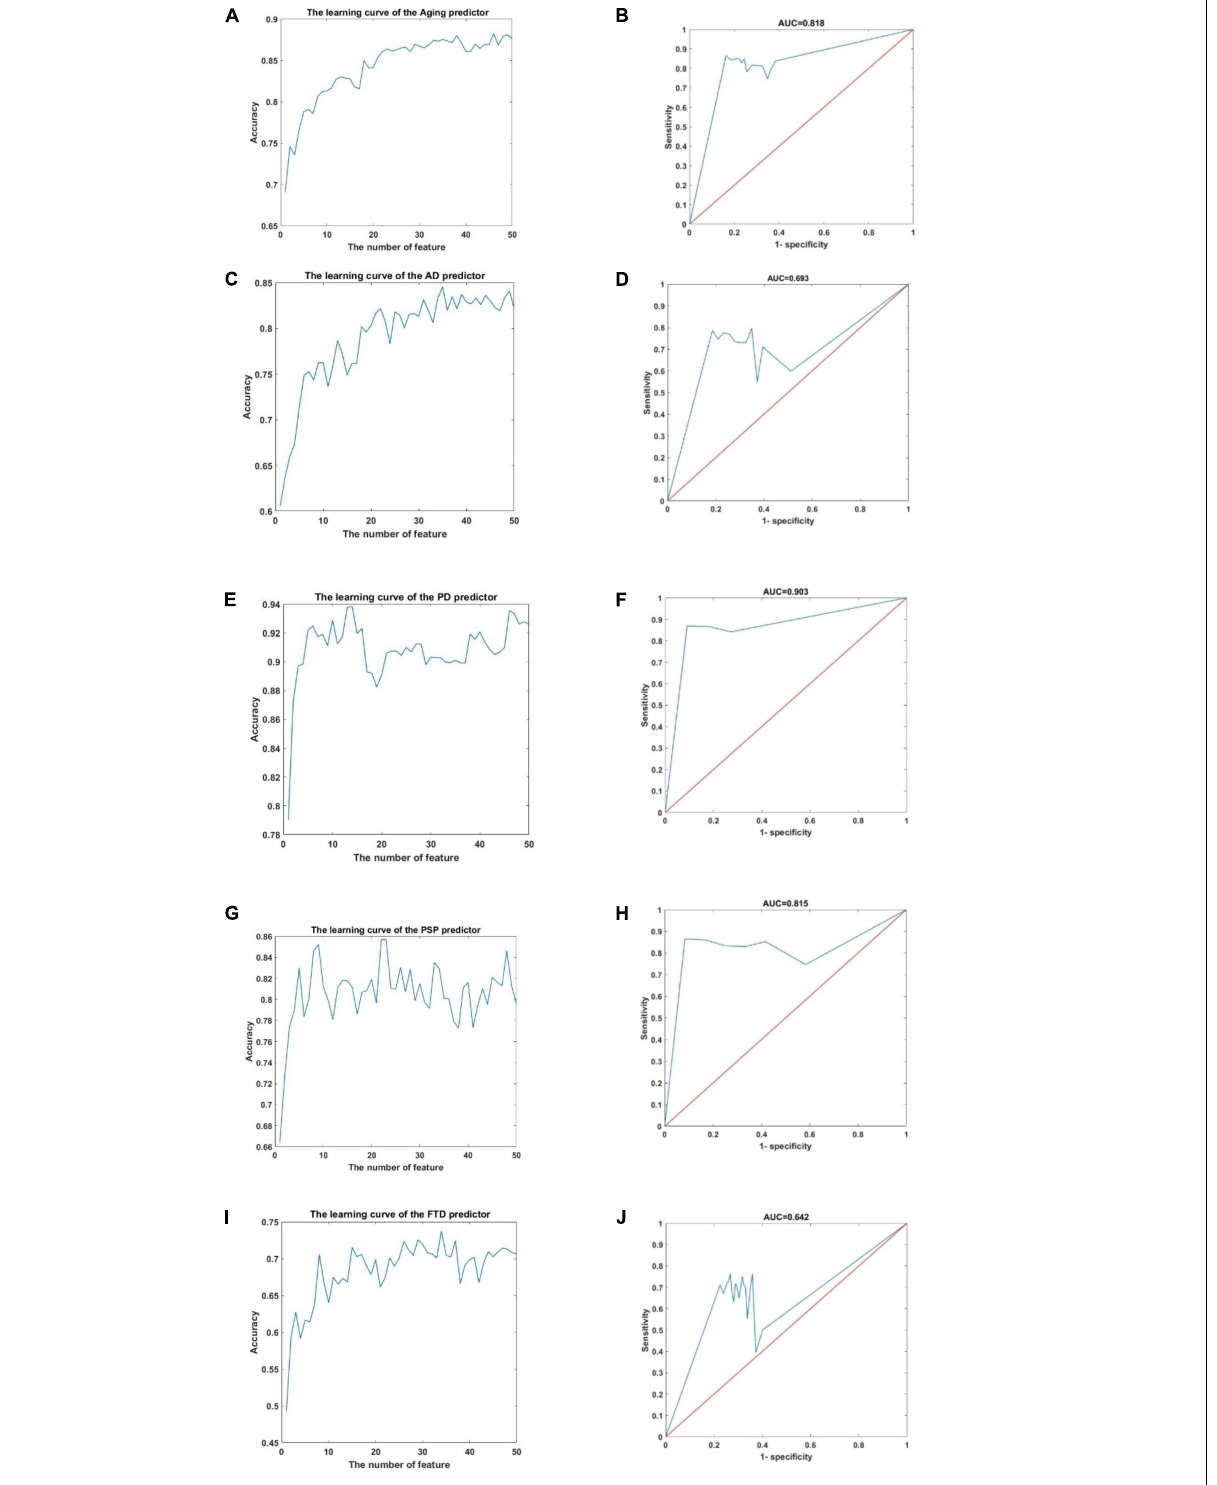
FIGURE 2 | The learning curve and ROC curve in the aging predictor and improved PD predictor. (A) The learning curve of the aging predictor. (B) The ROC curve of the aging predictor. (C) The learning curve of the AD predictor. (D) The ROC curve of the AD predictor. (E) The learning curve of the PD predictor. (F) The ROC curve of the PD predictor. (G) The learning curve of the PSP predictor. (H) The ROC curve of the PSP predictor. (I) The learning curve of the FTD predictor. (J) The ROC curve of the FTD predictor.